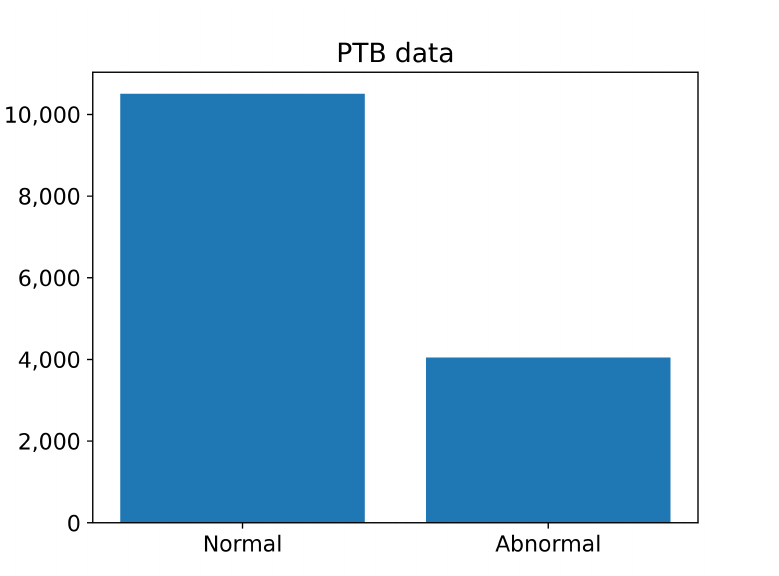
Figure 8. The number of normal and abnormal images of the PTB Diagnostics dataset. We used the finite impulse response bandpass filter (FIR) [52], a time-frequency transform plane, to transform a single-channel ECG signal into a four-channel ECG signal. Then, for each channel, we used sliding window segmentation on a sequence of segments of equal length to divide x ( i ) ε R n , as shown in Table